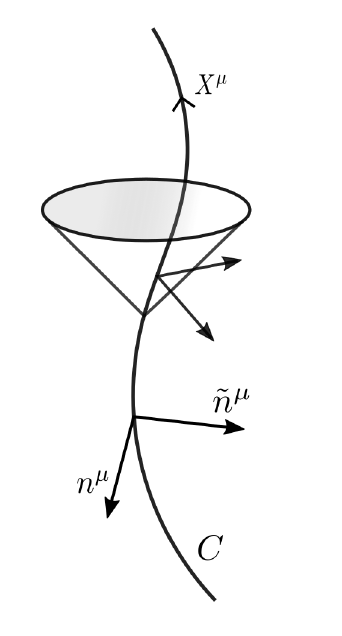
Figure 5: The topological Chern-Simons term in the TMG action introduces a normal frame defined by two auxiliary normal vectors n and ˜ n at each point on the worldline of a massive spinning particle. Figure modified from [ 66 ]